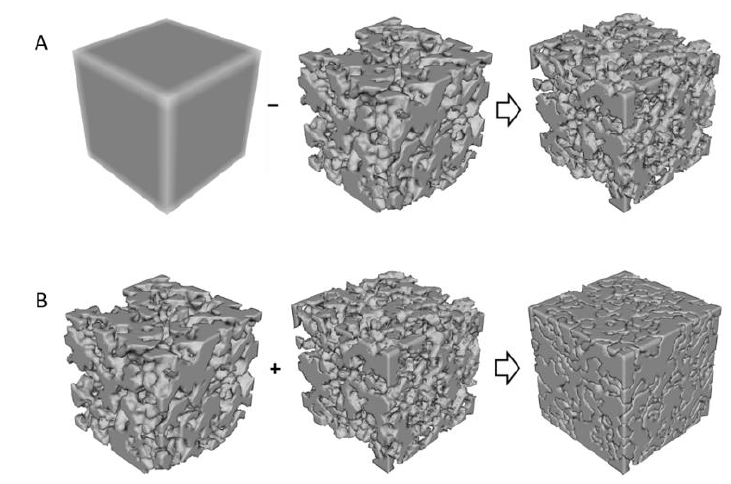
Figure 3. ( A ) Boolean operation producing porous geometry specimens, ( B ) producing composite structure specimens.